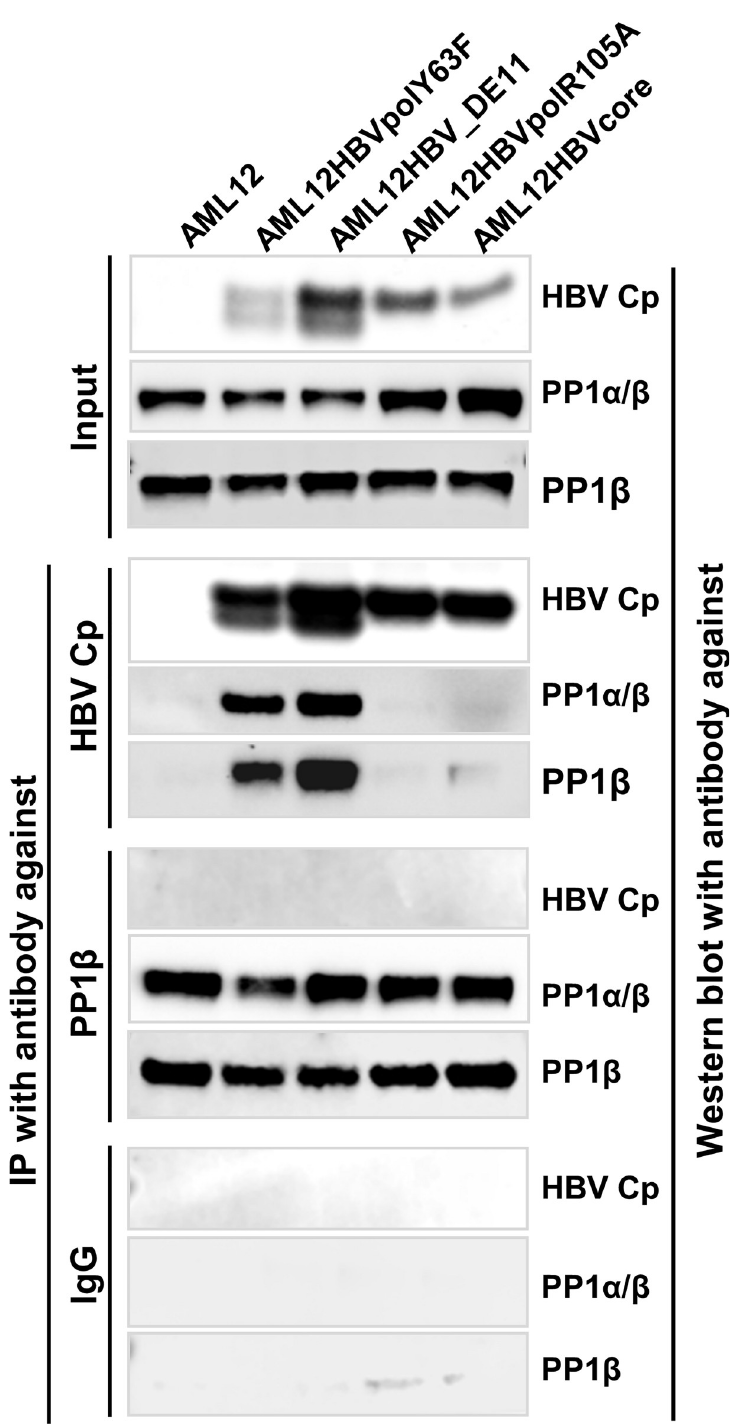
Fig 5. PP1 α / β was encapsidated into pgRNA and DNA-containing nucleocapsids. AML12 and its derived cell lines supporting tet-off inducible accumulation of empty capsids (AML12HBVcore and AML12HBVpolR105A), pgRNA- containing (AML12HBVpolY63F) and both pgRNA- and DNA-containing (AML12HBV_DE11) nucleocapsids were cultured in the absence of tet for 2 days. The cells were lysed with IP lysis buffer. IP assays were performed with an antibody against HBV Cp, PP1 β or control IgG. HBV Cp, PP1 α and/or β in input cell lysates and immunocomplexes of IP were detected by Western blot assays with the corresponding antibodies.